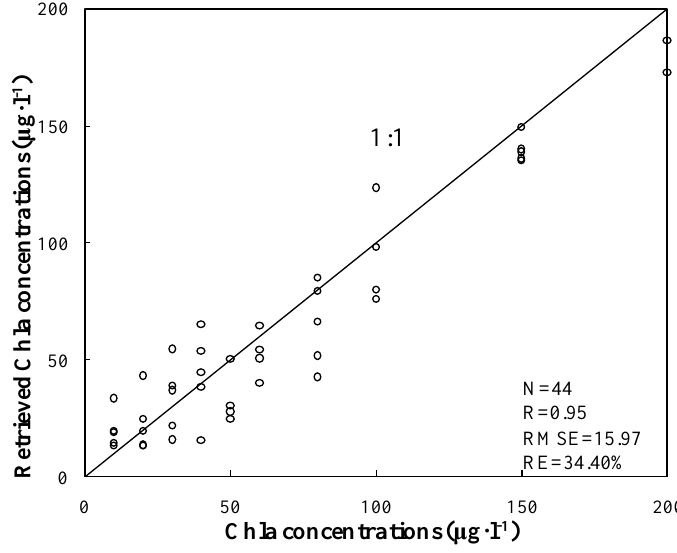
decomposition model.